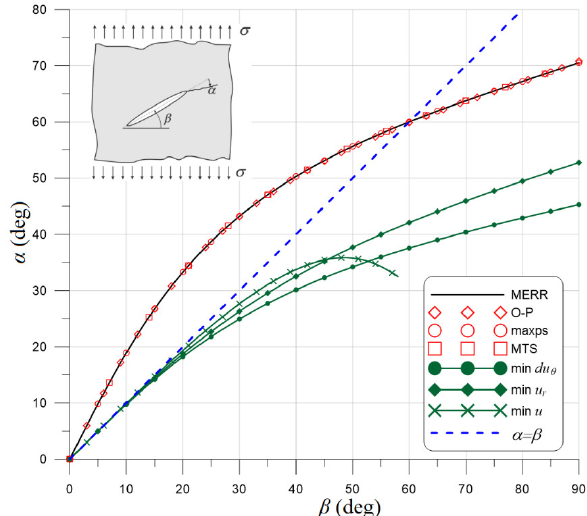
Figure 10. Comparison of the implemented criteria predicting the direction of the crack propagation with the maximum energy release rate (MERR) criterion. O–P: minimum gradient of the effort func- tion for the Ottosen–Podg ó rski failure criterion, maxps: maximum principal stress, MTS: maximum circumferential tensile stress, displacements criteria: (min du θ , min u r , min u ), α = β : direction normal to applied